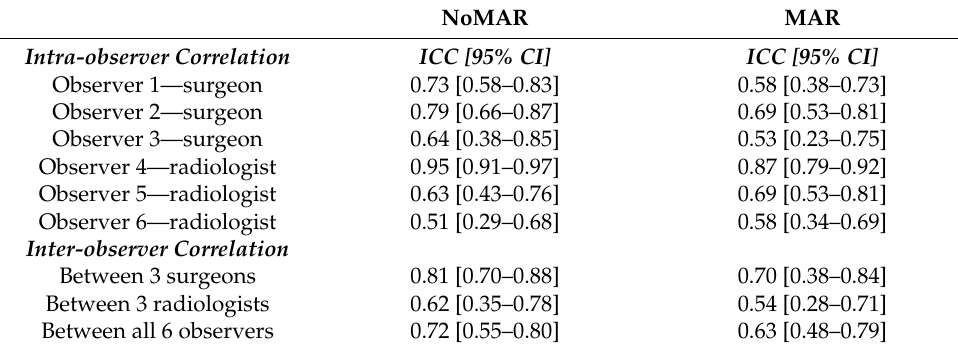
Table 2. Intra-class correlation coefficients and 95% credible intervals for the image quality scale without (NoMAR) and with metal artifact reduction algorithm